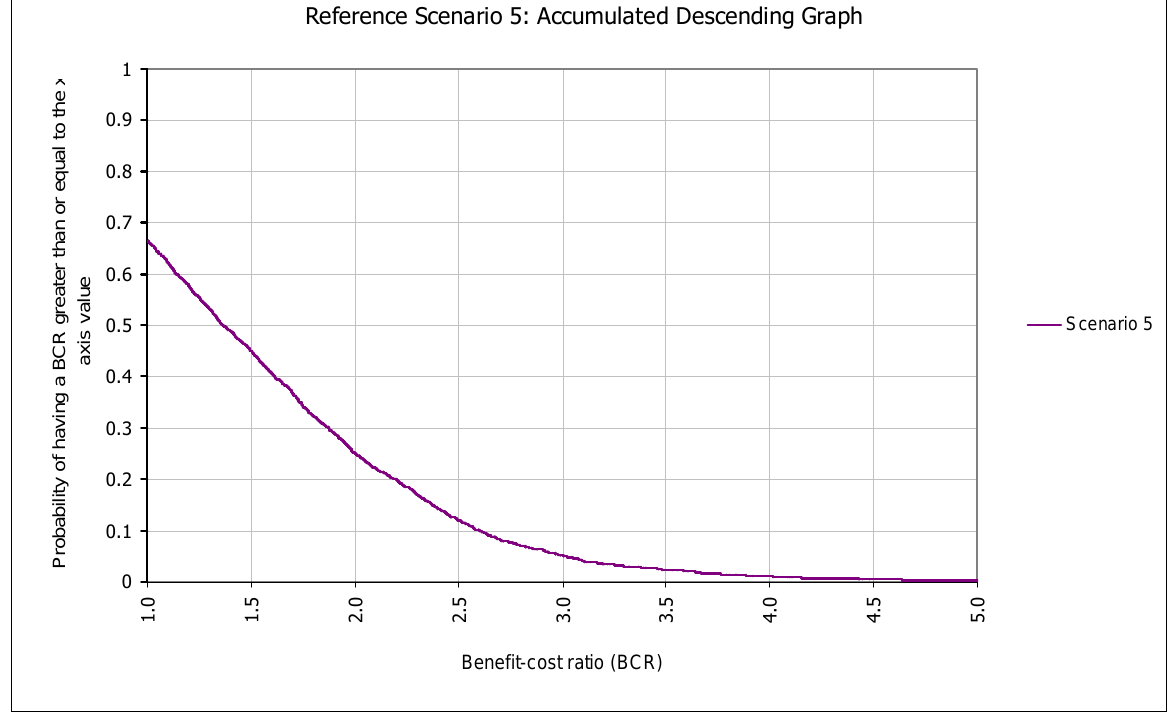
Figure 5. Resulting accumulated descending graph (ADG) for the focal scenario 5: the y-axis values for BCR = 1.0 indicate the certainty levels of the